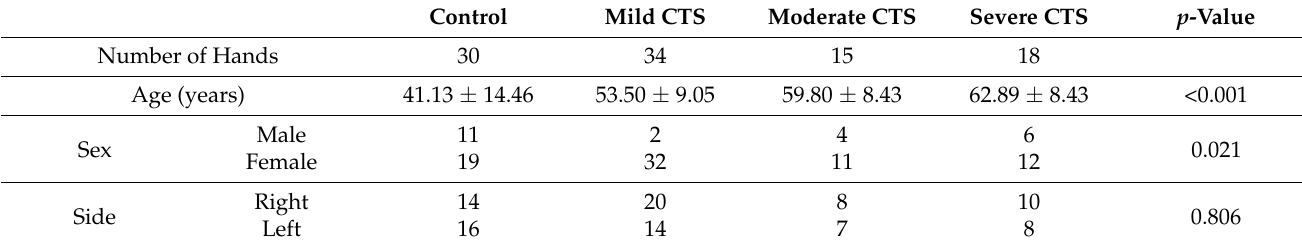
Table 2. Demographic characteristics of the subjects.